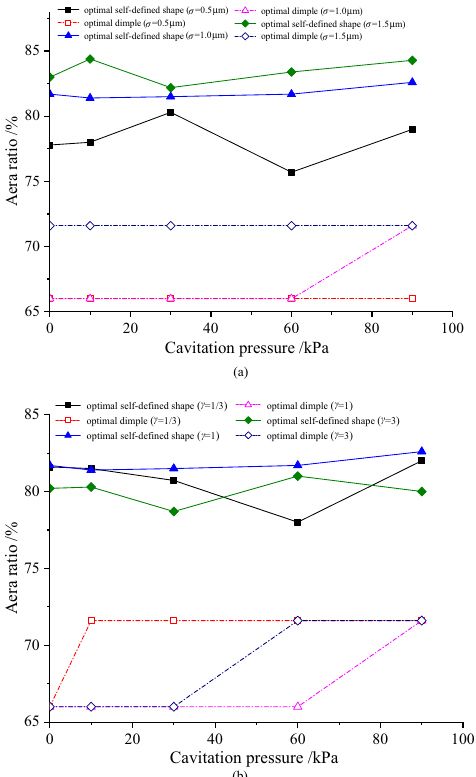
Figure 13. Variation of the area ratio with cavitation pressure.